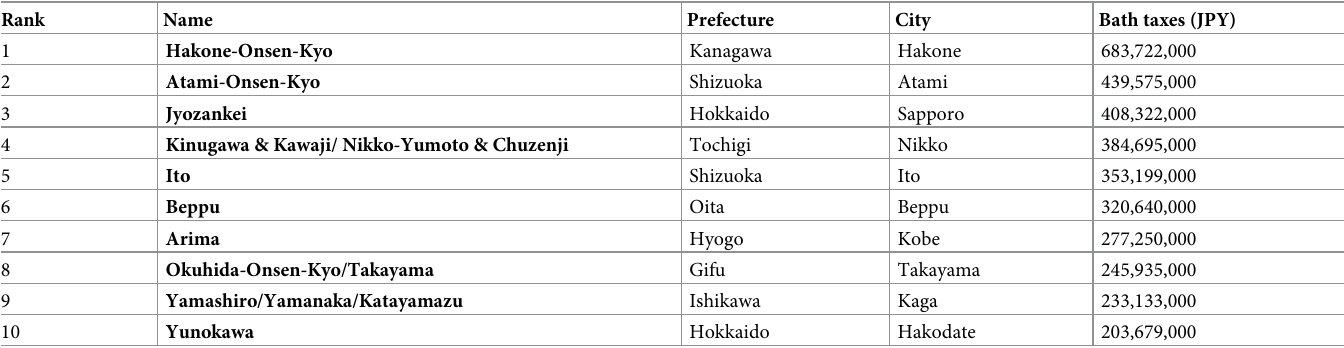
Table 1. Top 10 hot spring destinations ranked by number of the bath tax revenue in 2010 (Source: Nihon Onsen Kyoukai [33]).